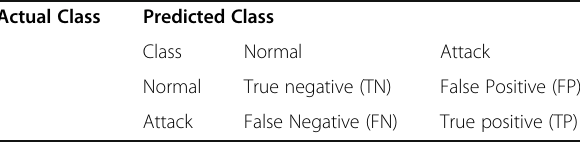
Table 7 Confusion matrix for IDS system Actual